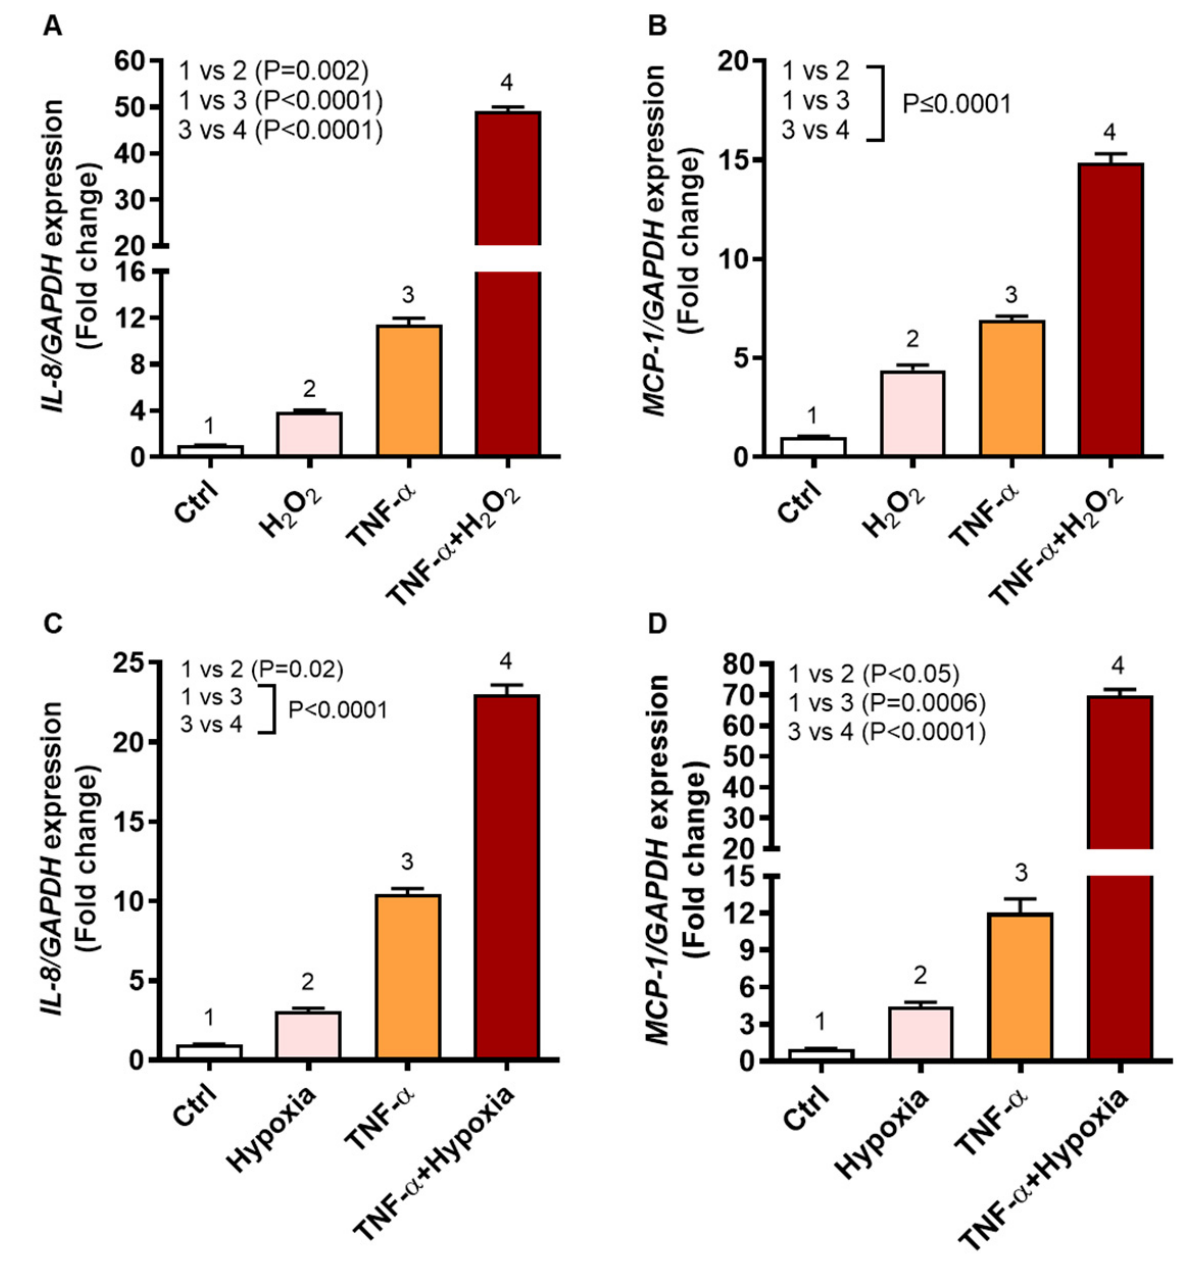
Figure 2. IL8 and MCP1 gene expression in human monocytic THP-1 cells stimulated with TNF- α and/or oxidative stress. THP-1 cells were stimulated, in triplicate, with TNF- α (10 ng/mL) and/or H 2 O 2 (10 mM) for 24 h while control cells were treated with vehicle only. Likewise, THP-1 cells were also stimulated, in triplicate, with TNF- α under oxidative stress by 1% hypoxia. Total RNA was collected from cells for measuring gene expression of IL8 and MCP1 using qRT-PCR as detailed in methods. One-way ANOVA (Tukey’s multiple comparisons test) was used to calculate group differences and p -values less than 0.05 were considered as significant. The representative data (mean ± SEM) obtained from three independent experiments with similar results show the upregulated transcripts of ( A ) IL8 and ( B ) MCP1 in cells co-stimulated with TNF- α and H 2 O 2 , compared to TNF- α stimulation alone ( p ≤ 0.0001). Similarly, the representative data (mean ± SEM) from three independent experiments with similar results show increased transcripts expression of ( C ) IL8 and ( D ) MCP1 in the cells stimulated with TNF- α under 1% hypoxia, compared to TNF- α stimulation under normoxia (20% O 2 ) ( p <